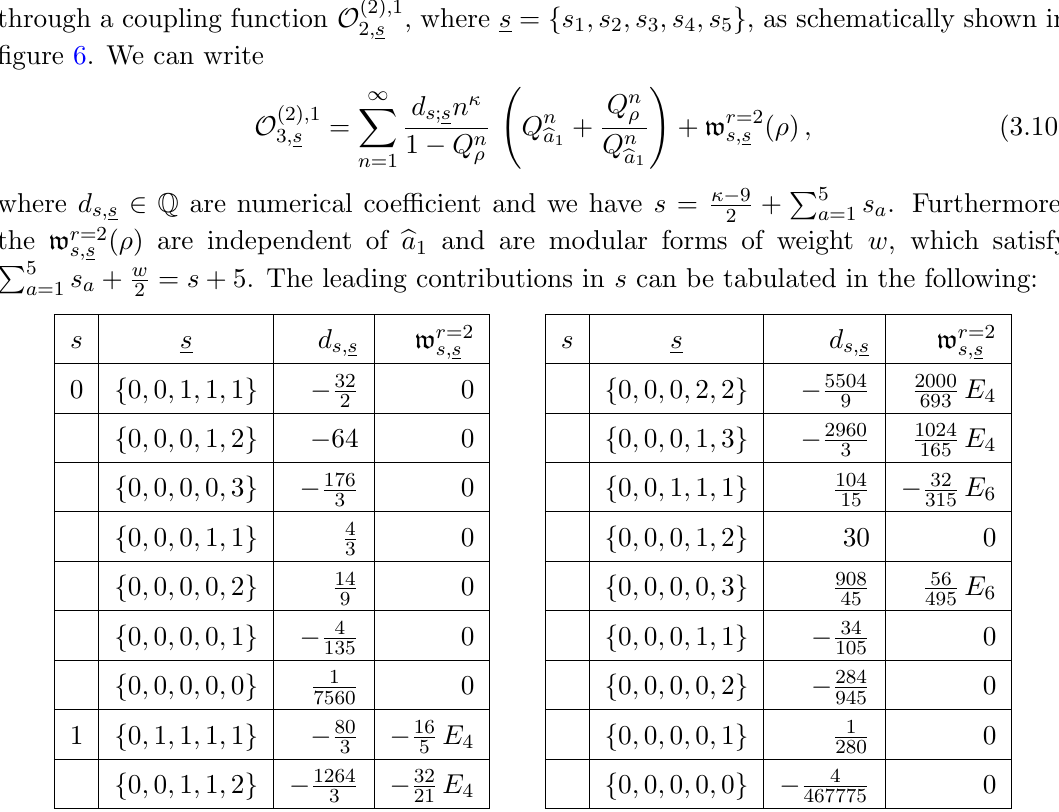
to (cid:12)ve H (1 ; 2) through O (2) ; 1 3 ;s (0) ( s i )